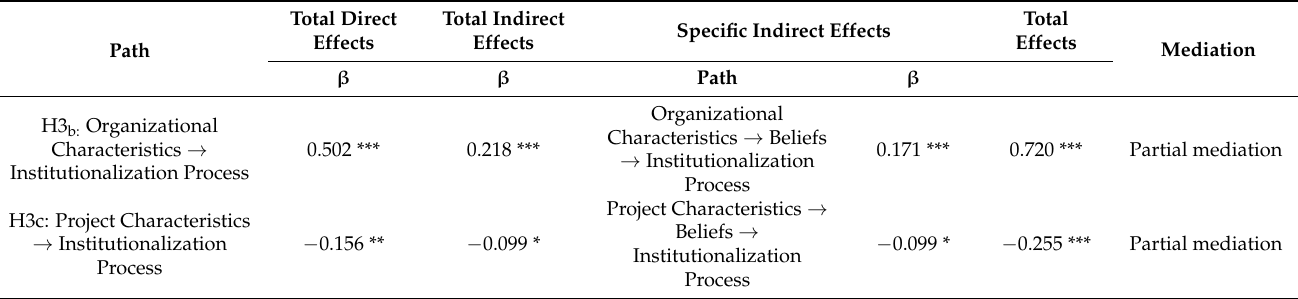
Table 4. Analysis of mediating